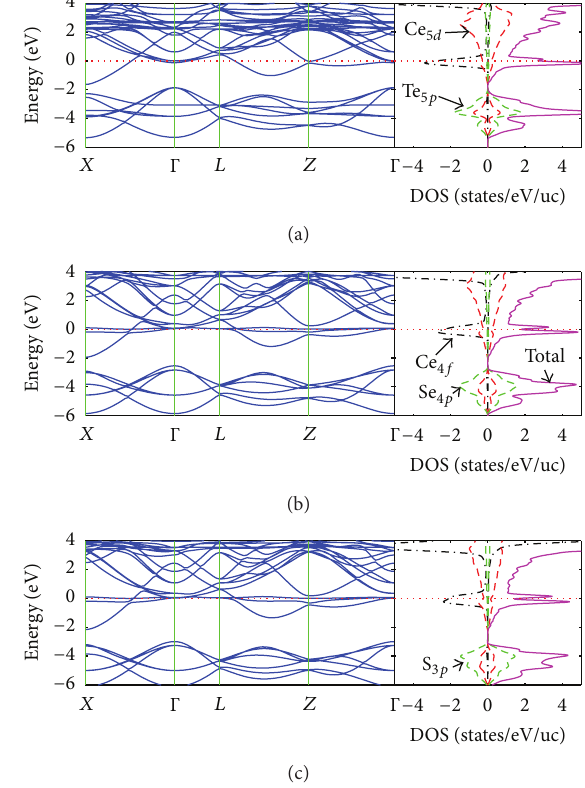
Figure 6: Same as 5 for GGA + 𝑈 with 𝑈 = 6